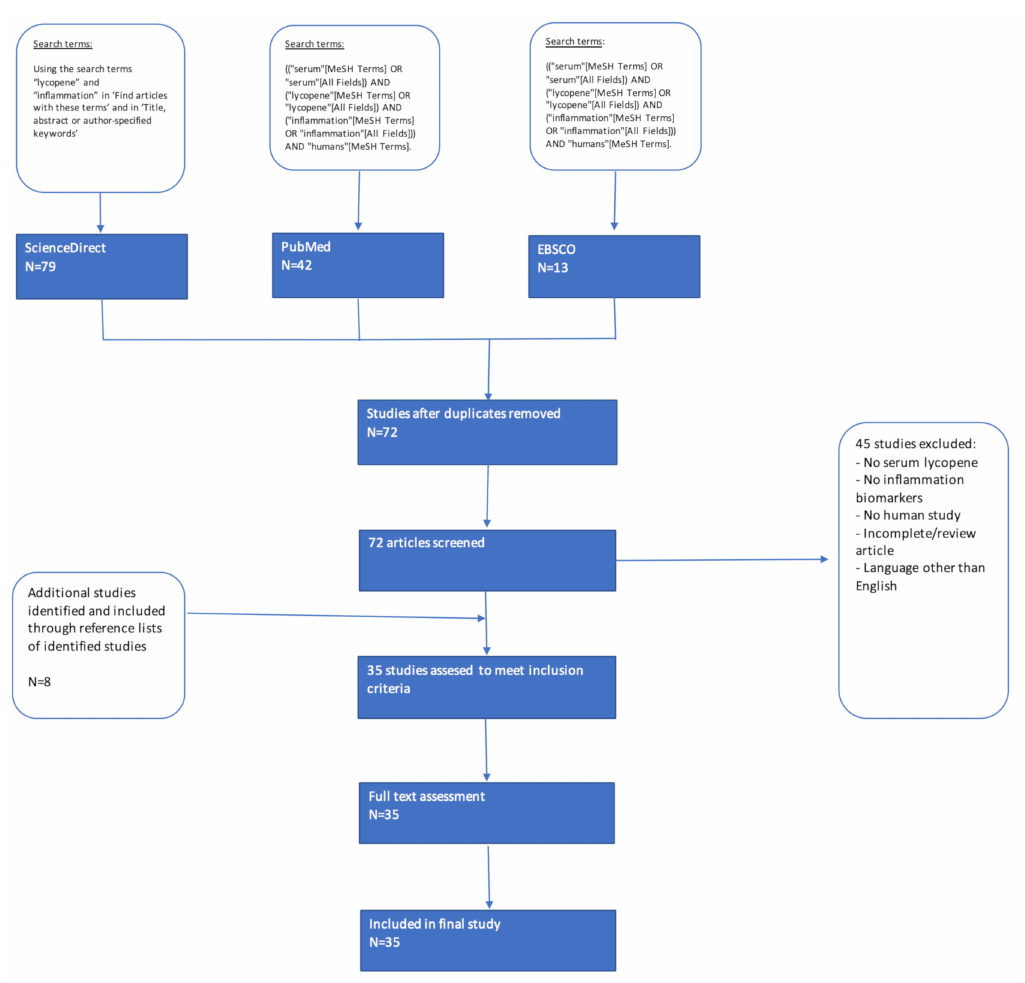
Figure 1. Flowchart of systematic search